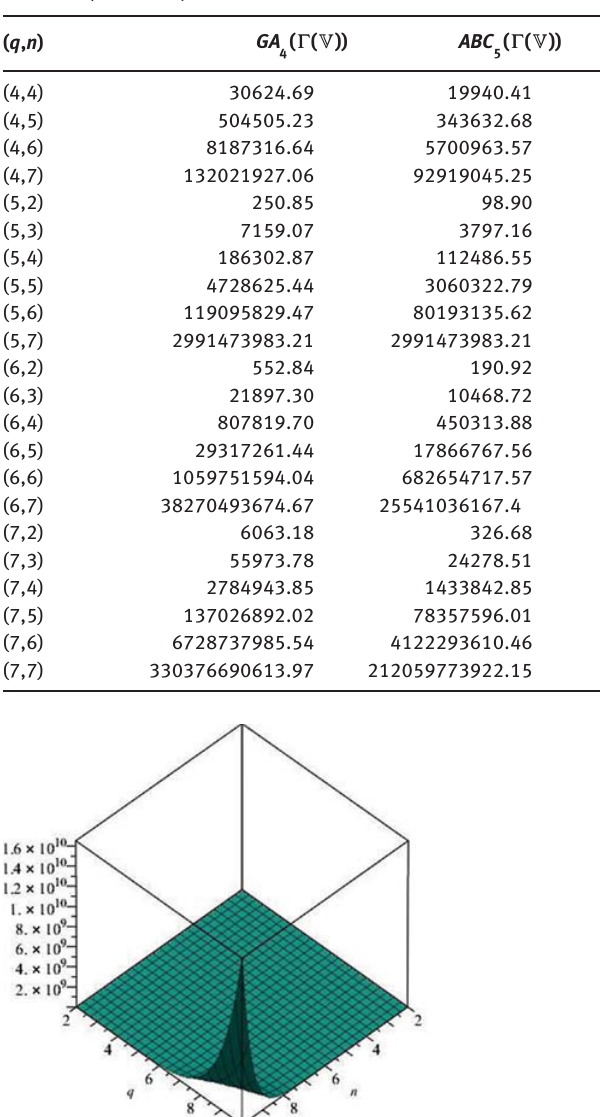
Figure 3: Plot of ξ ce .